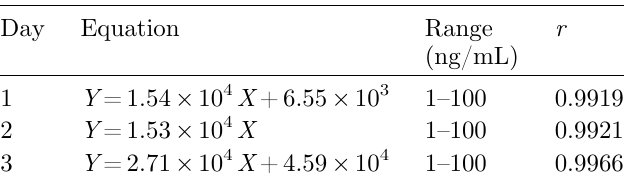
Table 9. Example of linear regression analysis of standard solutions for a 1 – 100 ng/mL concentration range, per- formed in 3 different days for cocaine by a HPLC/MS/MS method [22].